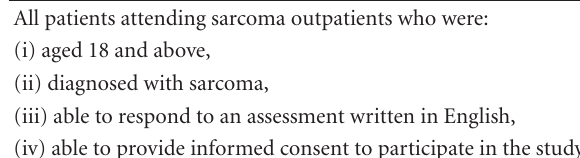
Table 1: Inclusion criteria for